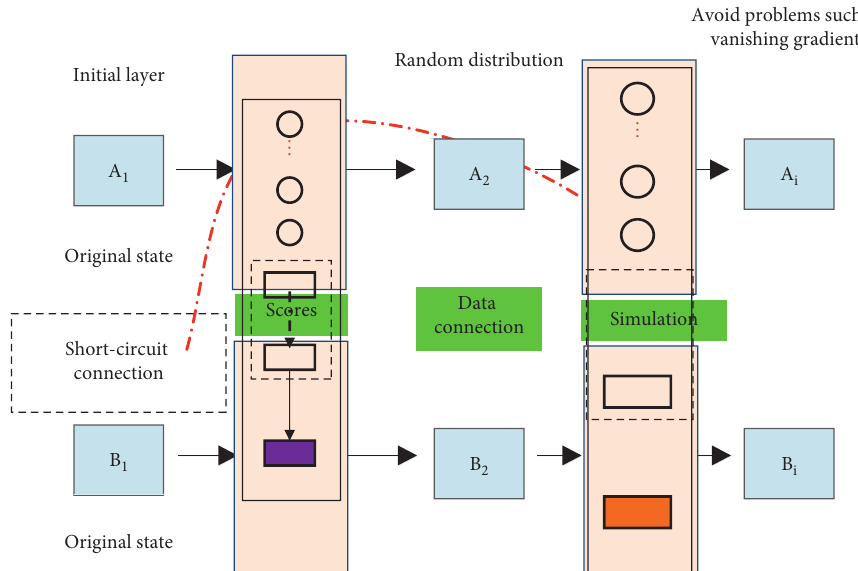
Figure 3: Decision tree representation.